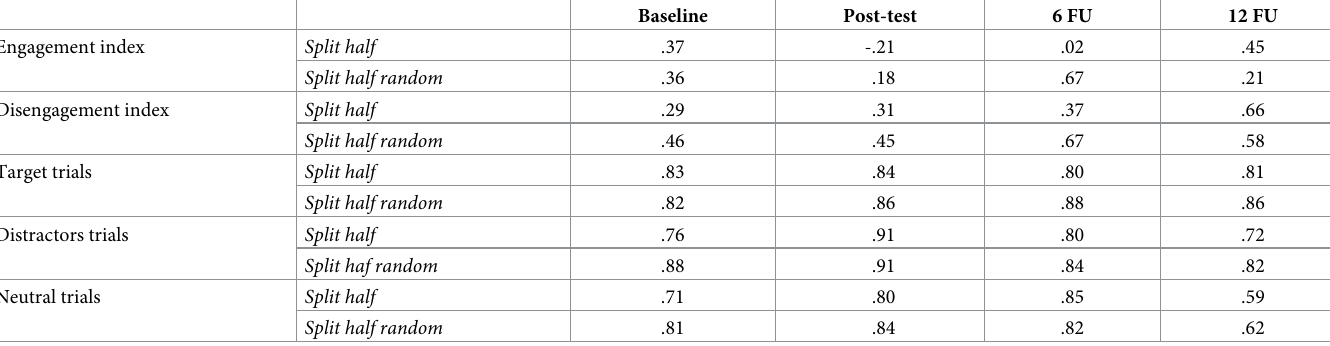
Table 2. Internal consistency of the AB indices and all trial types of the OOOT at baseline, post-test, 6 months and 12 months FU.